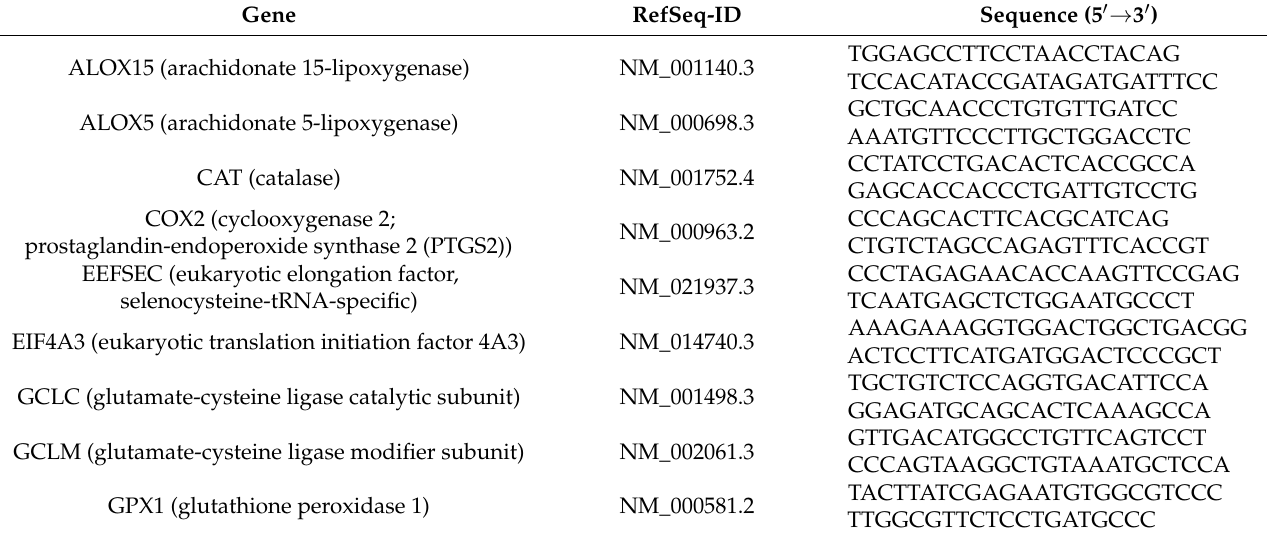
Table 1. Human-specific primers for quantitative real-time